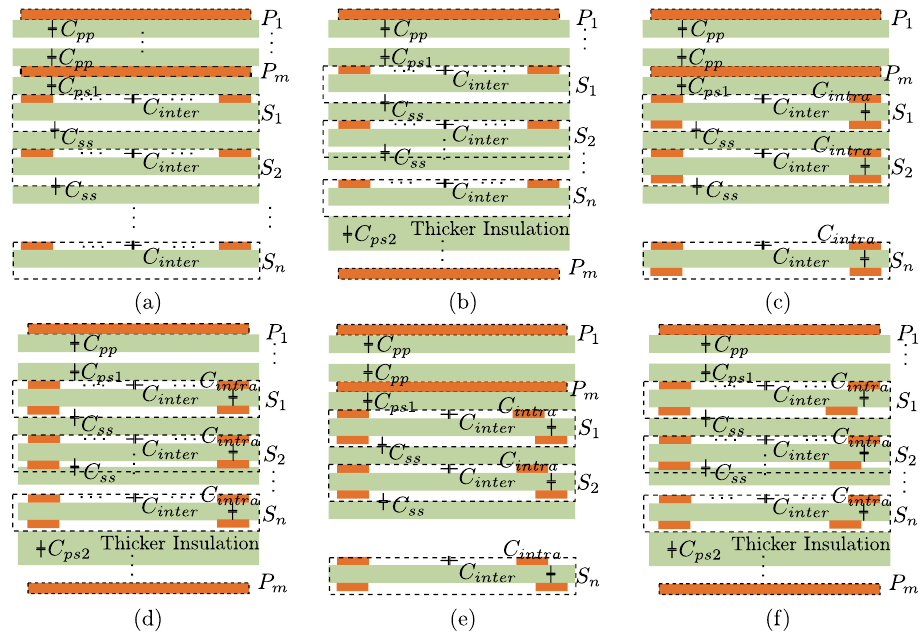
Figure 11. Multi-output transformer structures for high-voltage high-frequency applications: ( a ) W 1 (non-interleaved, single layer), ( b ) W 2 (partially-interleaved, single layer), ( c ) W 3 (non-interleaved, two-layered), ( d ) W 4 (partially-interleaved, two-layered), ( e ) W 5 (non-interleaved, non-overlapped), ( f ) W 6 (partially-interleaved, non-overlapped)